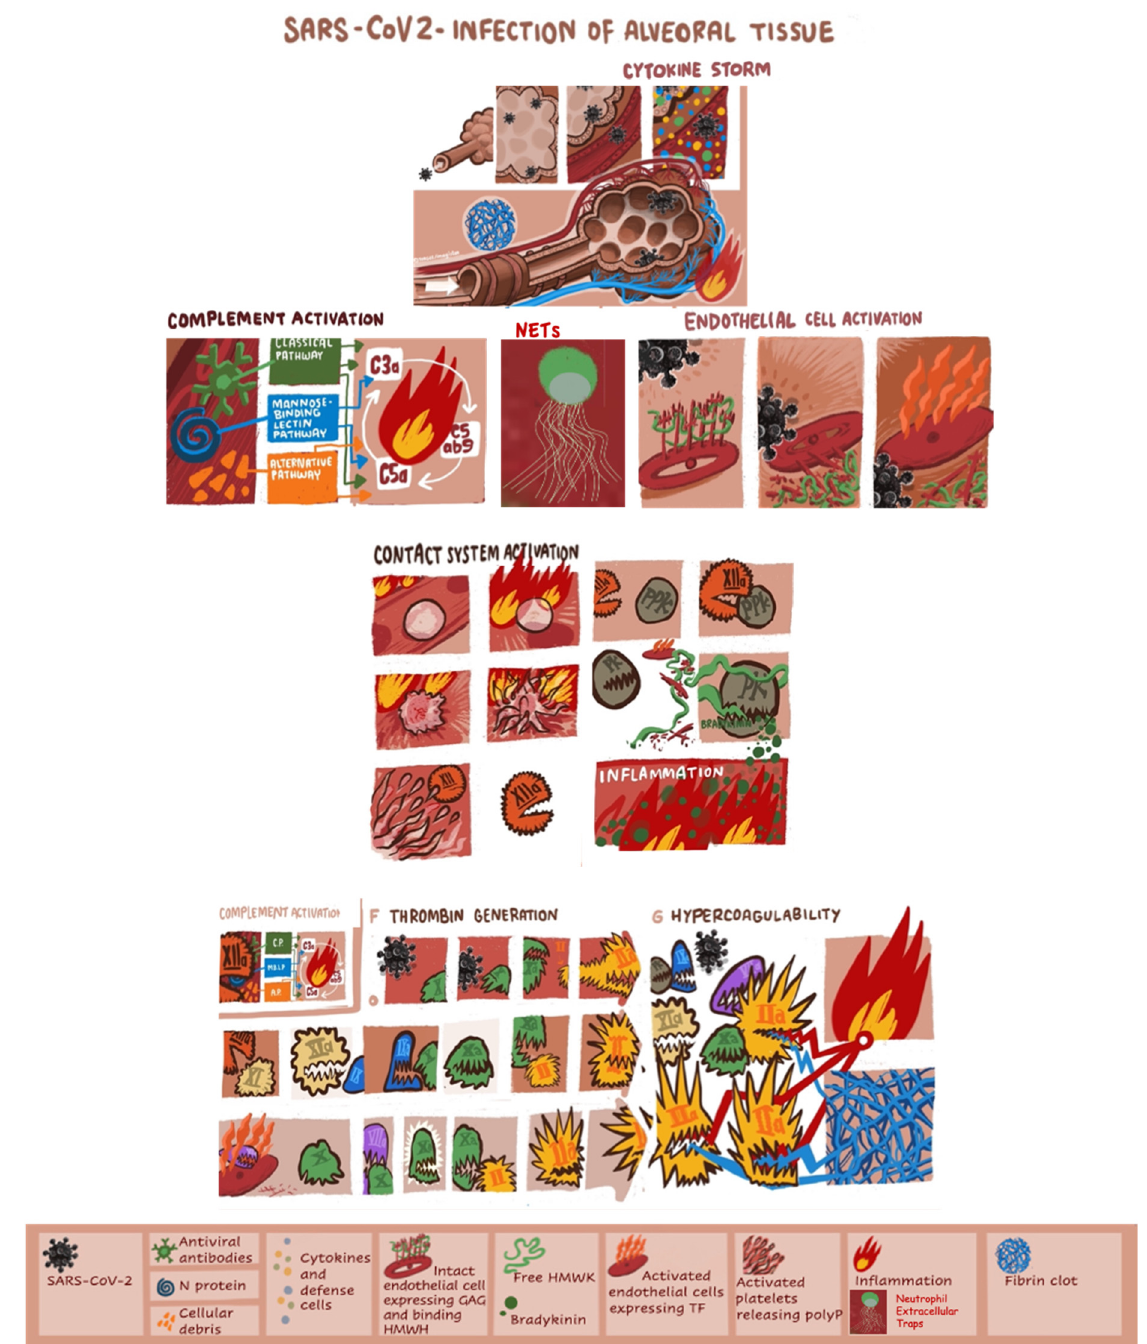
Figure 1. The principal mechanisms triggered by SARS-CoV-2 infection leading to hypercoagulability and pulmonary intravascular coagulation. GAG, glycosaminoglycans; HMWK, high-molecular- weight kininogen; IL, interleukin; INF, interferon; NET, neutrophil extracellular trap; PK, plasma kallikrein; PPK, plasma prekallikrein.